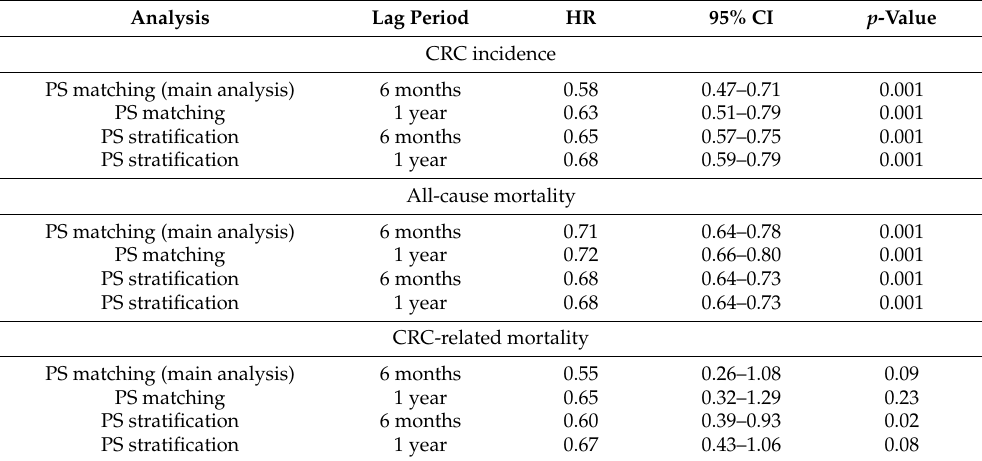
Table 3. Sensitivity analyses of metformin users for over 6